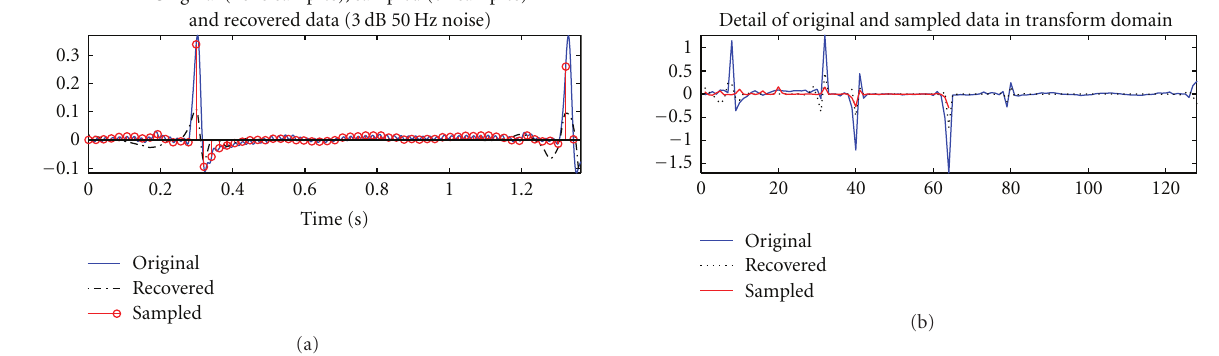
Figure 2: Original (continuous blue), sampled (continuous red), and reconstructed (dashed black) ECG signal from 64 samples. Depiction of time signal (a) and Daubechies 4 wavelet representation with level 4 of decomposition